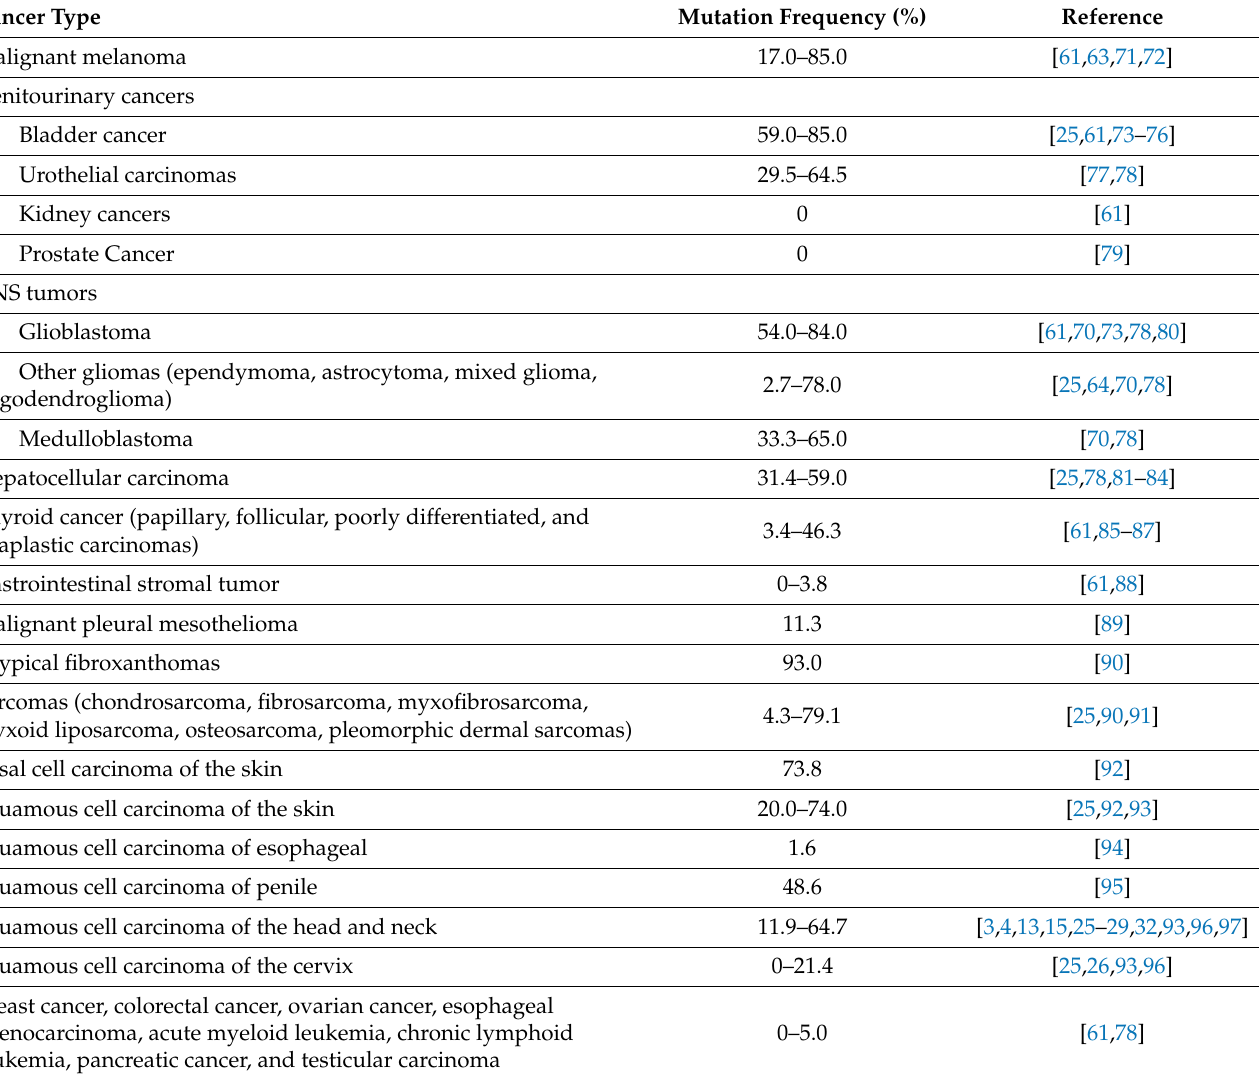
Table 1. Frequency spectrum of hTERT promoter mutations across different cancer